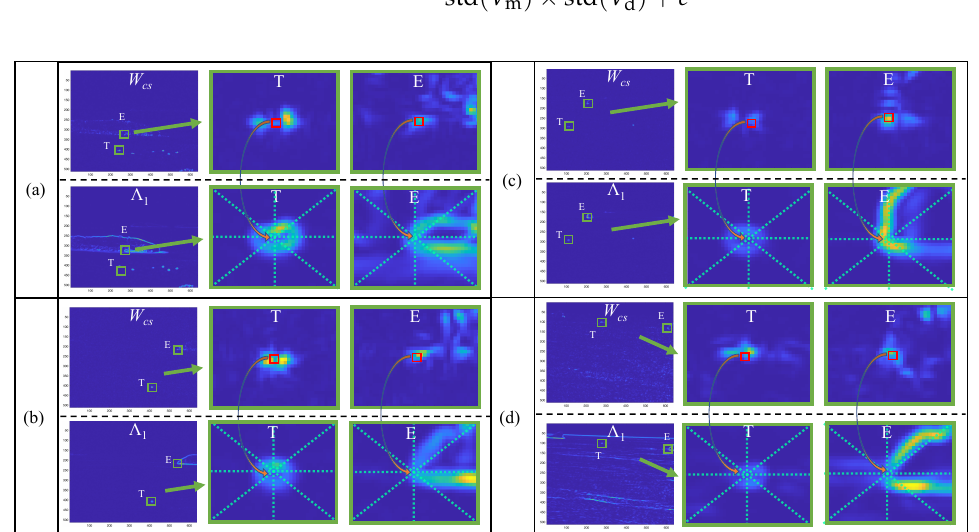
Figure 2. The relationship between corner strength map W cs and the eigenvalue Λ 1 of the struc- ture tensor. ( a – d ) are the results of four different typical scenes corresponding to Figure 1 in the process of the multidirectional